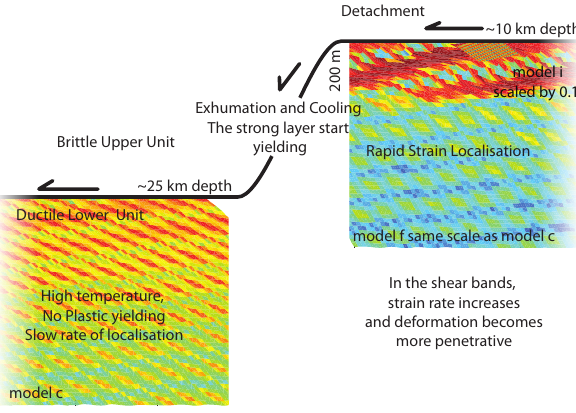
Fig. 10. Sketch model for shear localisation beneath a detachment fault. Layered rocks are initially at high temperature and large con- fining pressure corresponding to model c. The rapid cooling during exhumation causes the strong layers to start yielding. According to model f, this results in shear banding and rapid localisation of strain ( γ < 1). Within the shear bands, the strain rate is approximately in- creased by a factor of 10, corresponding to model i and resulting in more penetrative deformation and onset of